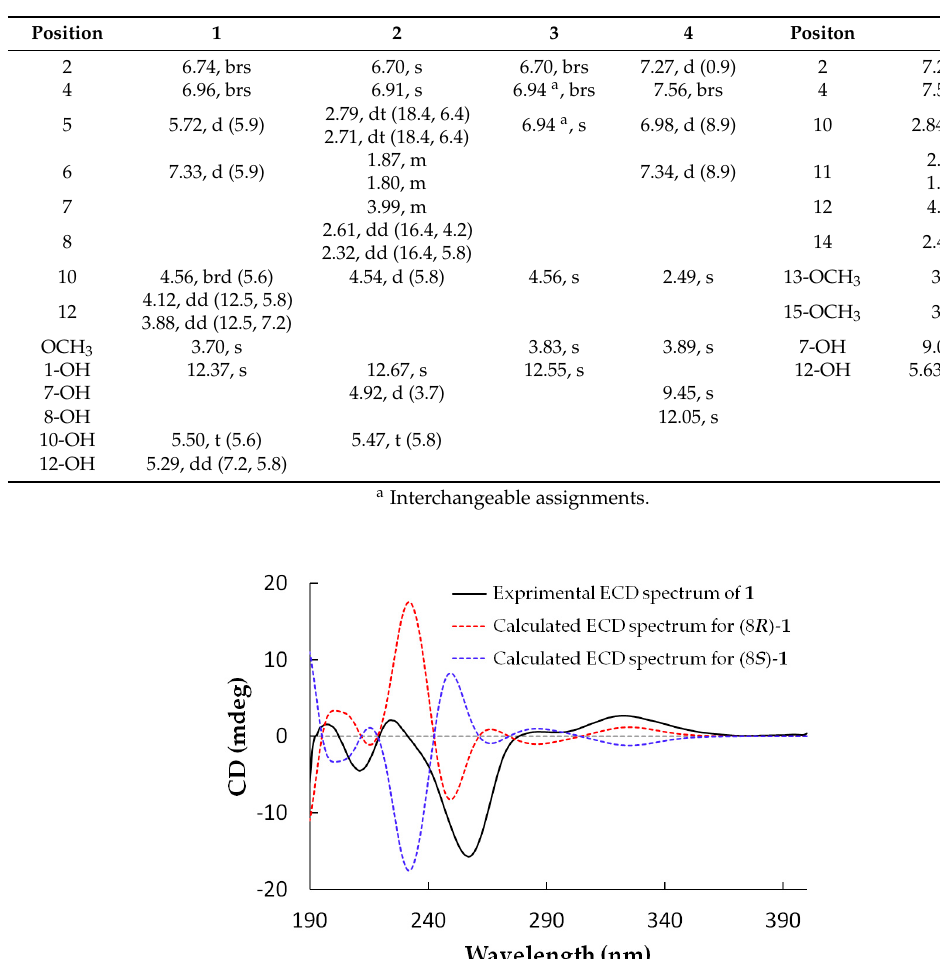
Figure 2. Key 2D-NMR correlations for 1 and 2 . Table 1. 1 H-NMR (600 MHz) data for 1 – 5 (DMSO- d 6 ).